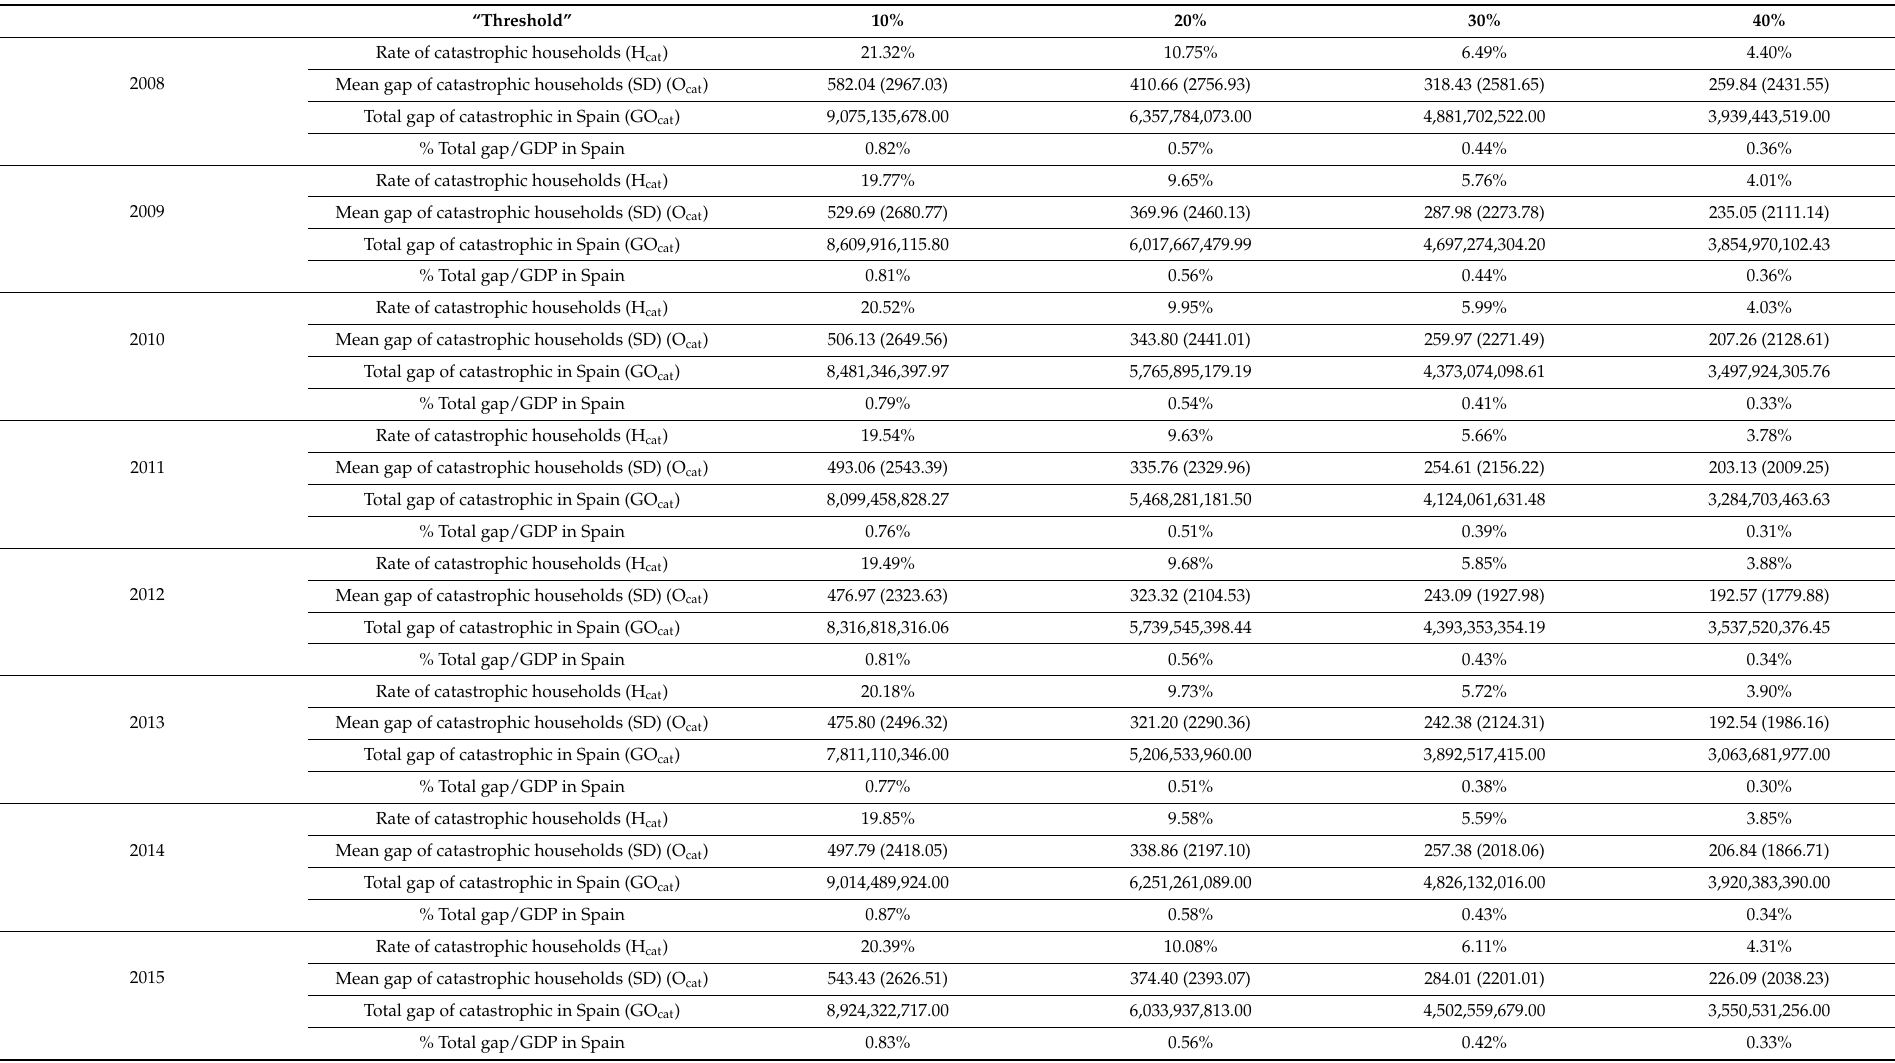
Table 4. Incidence, intensity, and total gap of financial catastrophism due to out-of-pocket payments in health in Spain (EUR). Period 2008–2015.